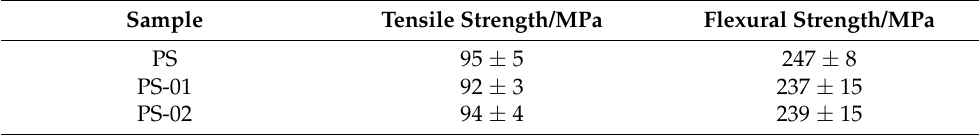
Table 5. Mechanical Properties of Neat PS and